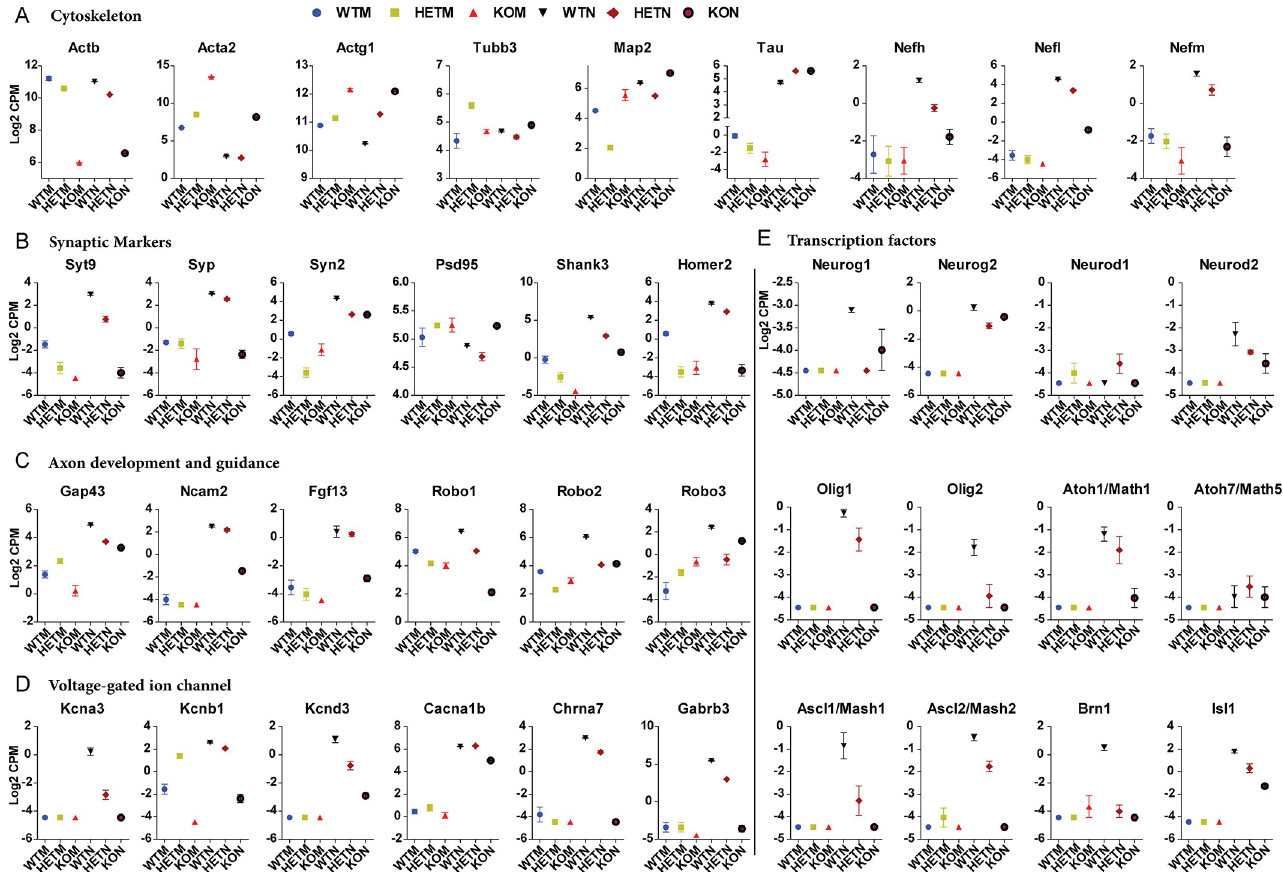
Fig 4. The expressions of different classes of genes in neurogenesis are affected by endogenous β -actin level. The relative expression levels of genes involved in (A) cytoskeleton, (B) synapse, (C) Axon development and guidance, (D) Voltage-gated ion channel and (E) Neuron-related transcription factors are shown in all MEFs and CiNeurons. The plots are the summary of at least 3 biological replicates from RNA-seq analysis. Error bar: